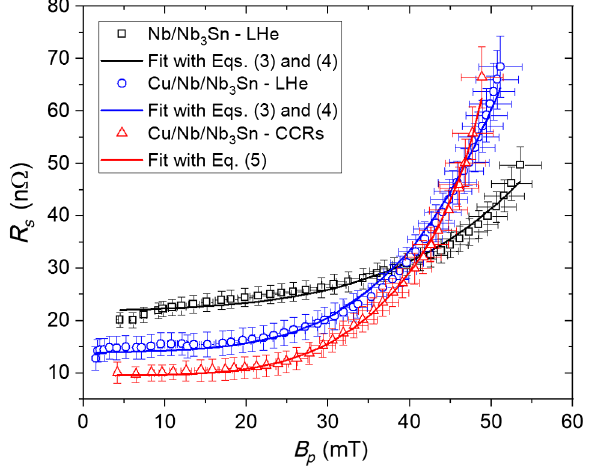
ð B Þ data for the Nb prototype cavity with Nb FIG. 33. R s p film on the inner surface cooled by LHe and with Cu outer layer tested both in LHe and with cryocoolers. Solid lines are least- squares fit to each